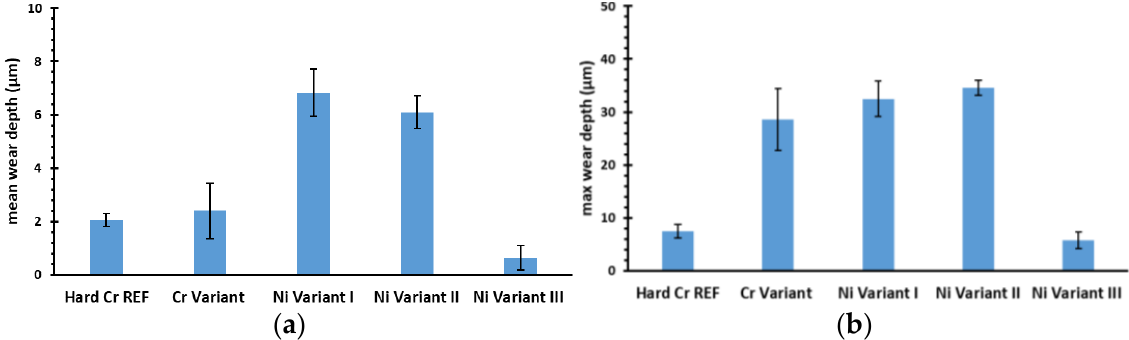
Figure 8. Comparison of ( a ) maximum and ( b ) mean wear depths for four candidate coatings and the hard Cr reference sliding against anodized Al rods under lubricated conditions.